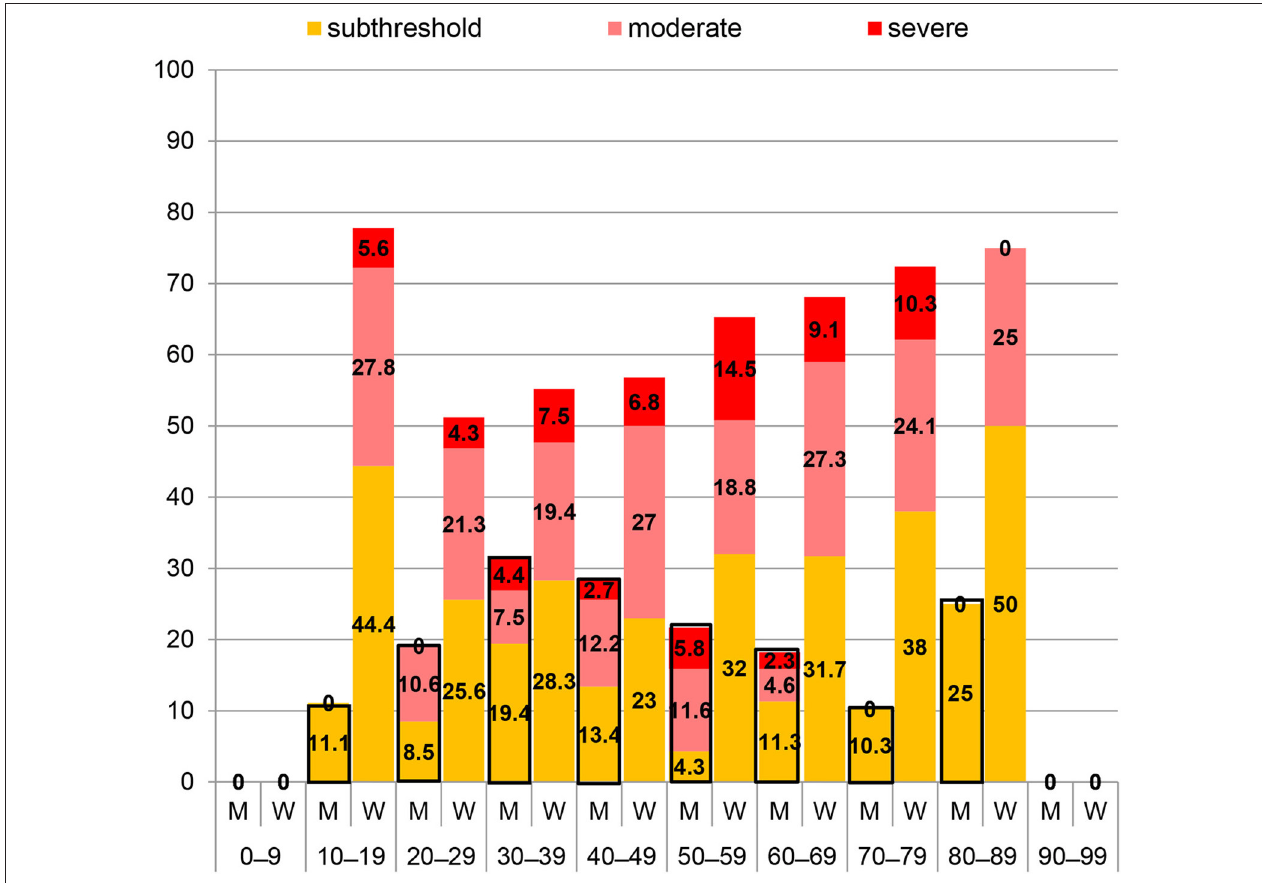
FIGURE 8 | Distributions of Insomnia Severity Index (ISI) categories including only scores ≥ 8 per decade among 97 men (M) and 255 women (W).